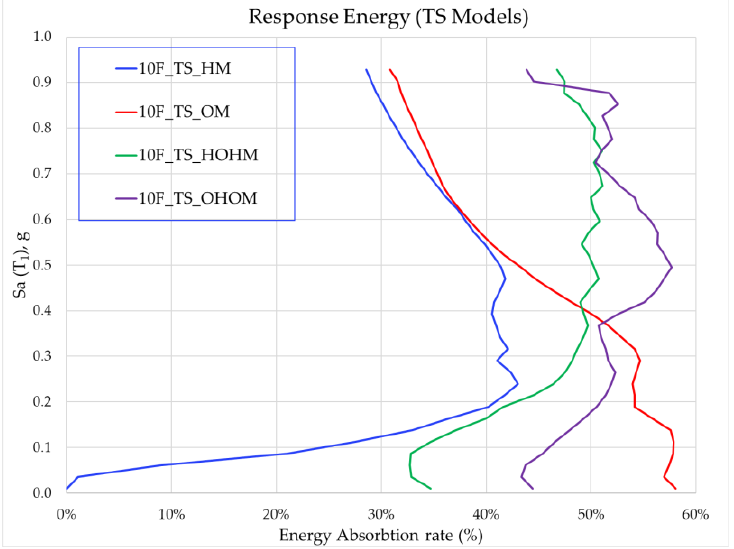
Figure 11. Energy response of all TS models.